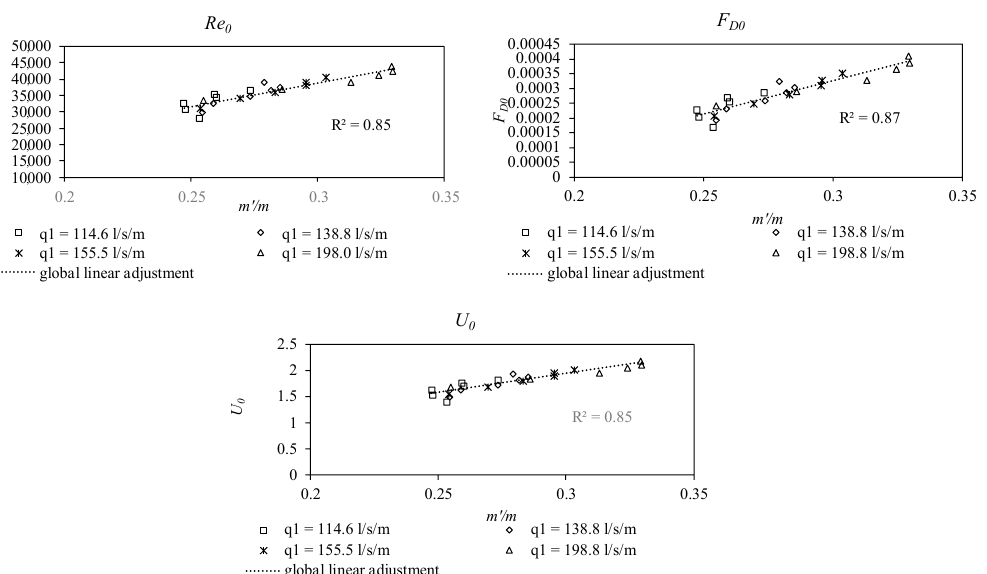
Figure 14. Velocity at the beginning of the rack, U 0 , as a function of the ratio between the effective and the initial void ratios, m’/m.